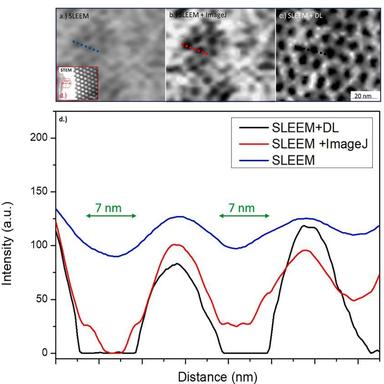
Comparison of cross-sectional SLEEM image obtained with 0.6 keV electron beam (a.) and SLEEM image improved with ImageJ program (b.) versus crosssectional deep learning-enhanced SLEEM image (c.) of Au-loaded SBA-15. The structure observed by STEM (d.) is also highlighted. The graph of the line profiles (highlighted in the images) presents increasing dynamic range which is important for the structural size measurements.